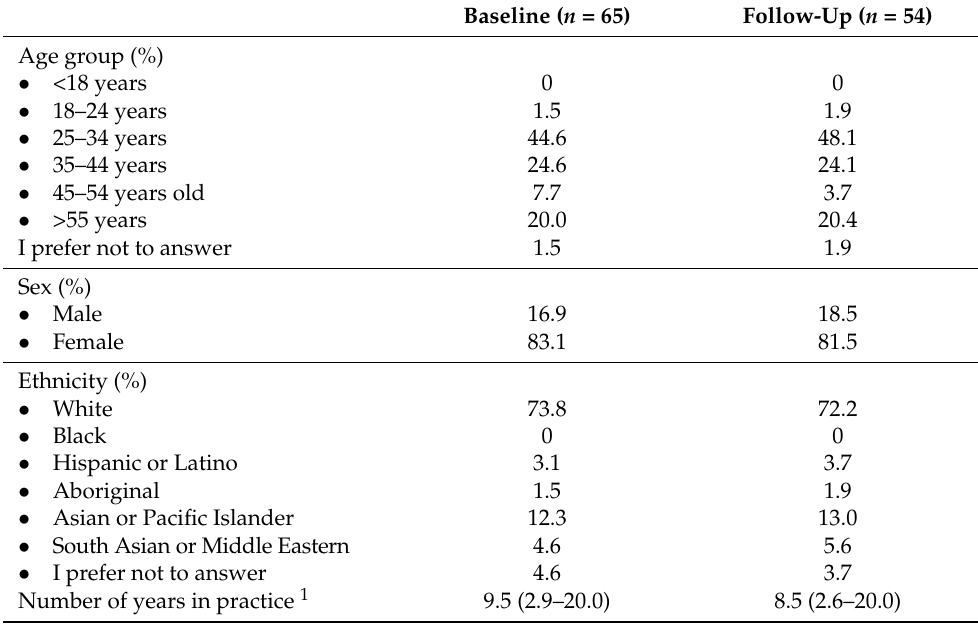
Table 2. Participant Characteristics.